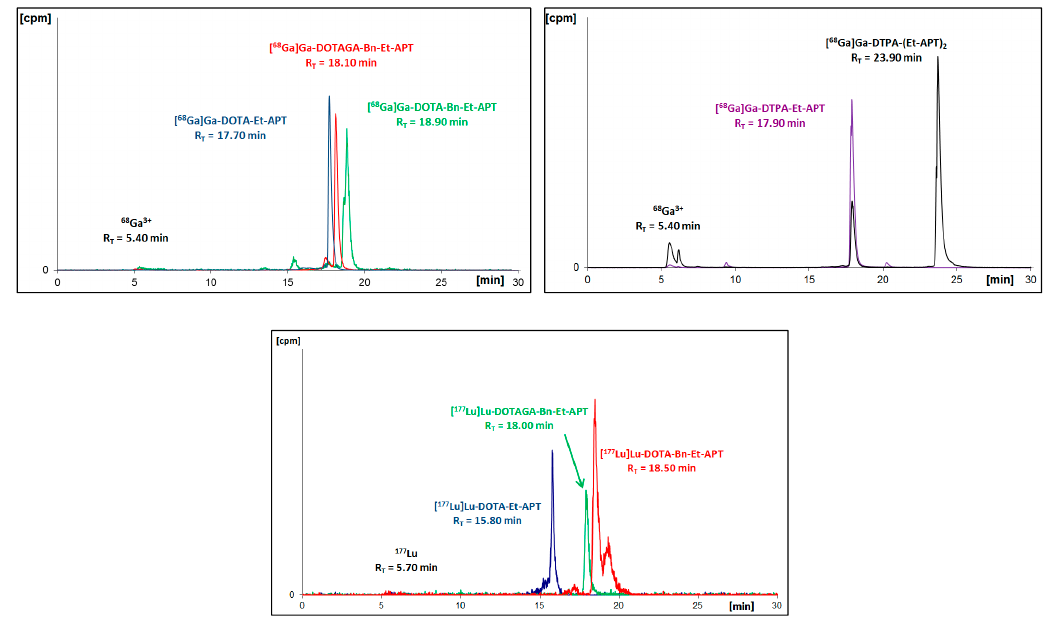
Figure 2. Radiochromatograms of aprepitant (APT) ‐ ethylamine 2A conjugates with DOTA, Bn ‐ DOTA, Bn ‐ DOTAGA or DTPA radiolabeled with gallium ‐ 68 (upper two) or with lutetium ‐ 177 (bottom).